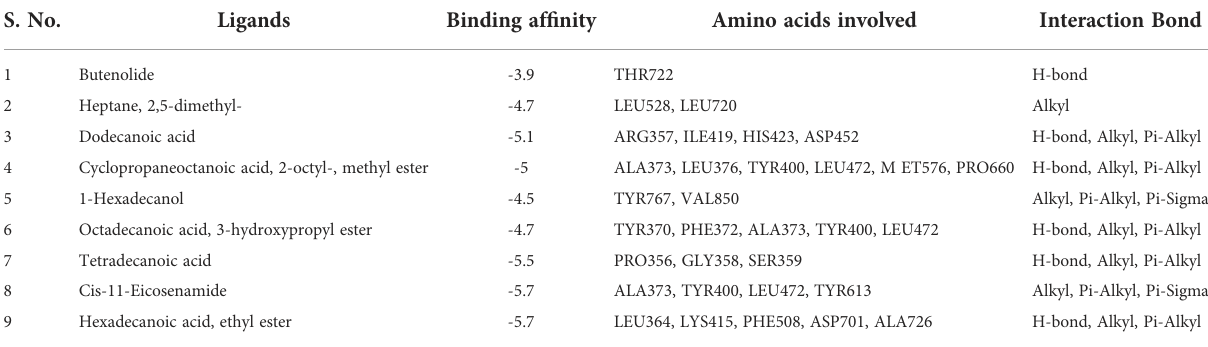
TABLE 4 The docking result of the compounds identi fi ed in the culture supernatant extract of the bacterium Alcanivorax sp. AA8 carried out using the software PyRx. S. No.